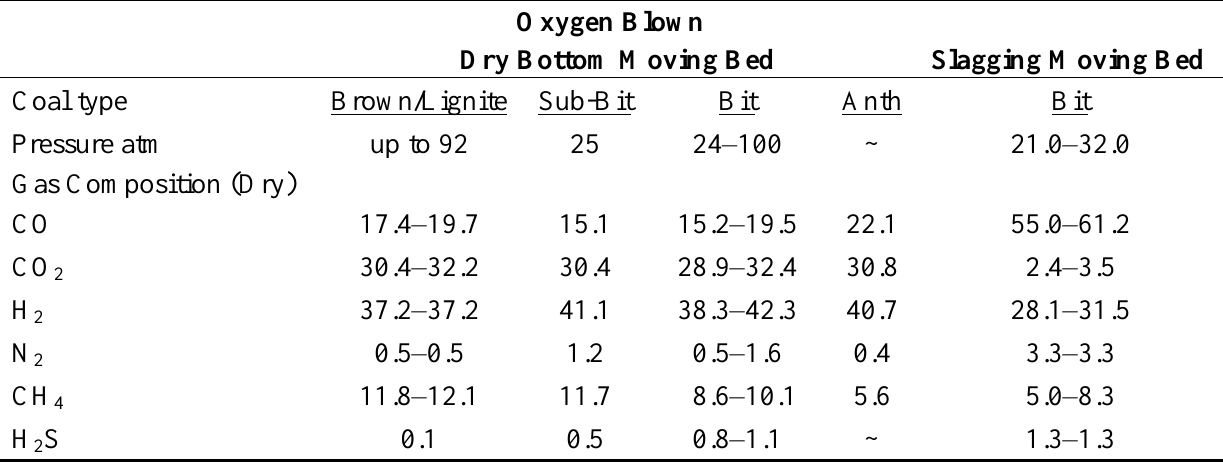
Table 4. Typical product compositions for oxygen blown moving bed gasifiers